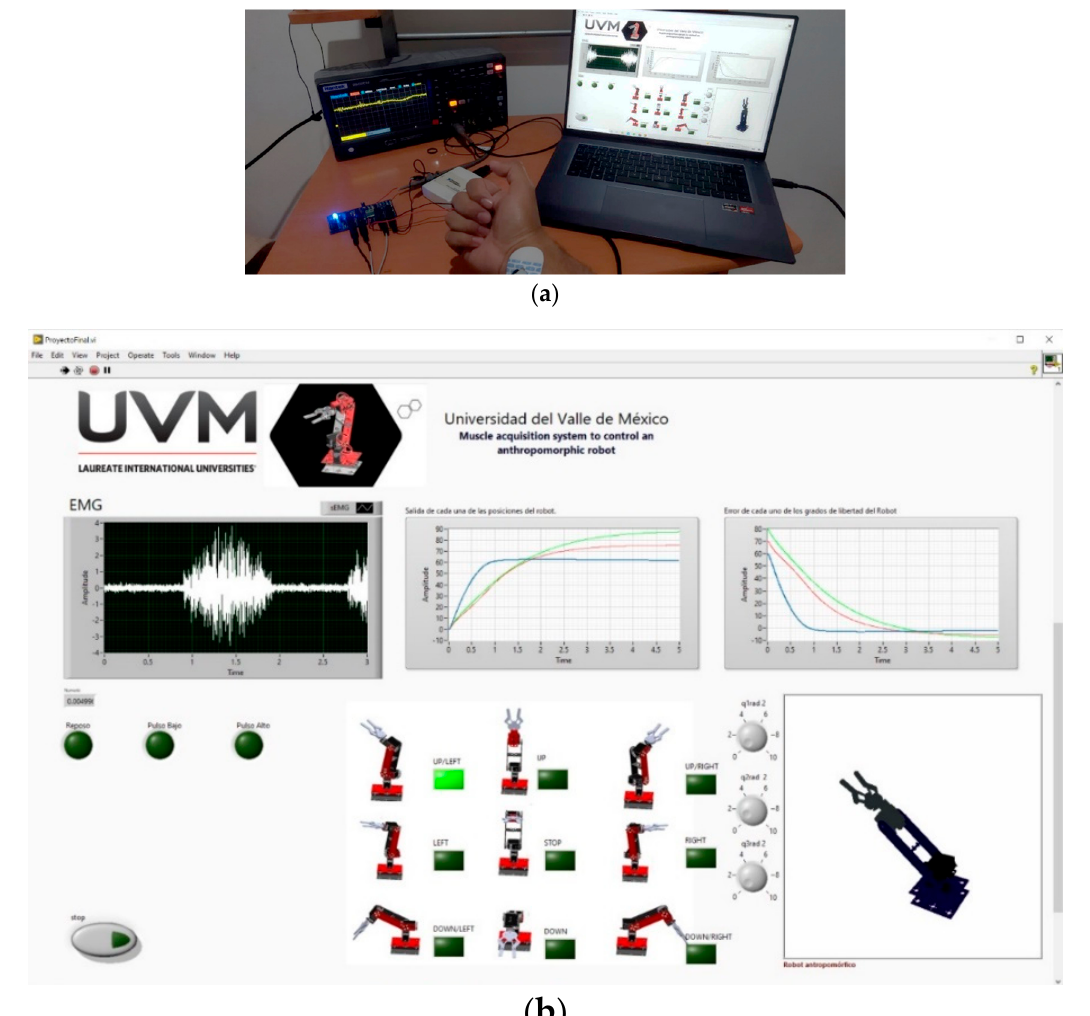
Figure 18. ( a ) Implementation of the real-time acquisition system interacting with the virtual robot simulation, ( b ) Graphical interface designed to record response time metrics.